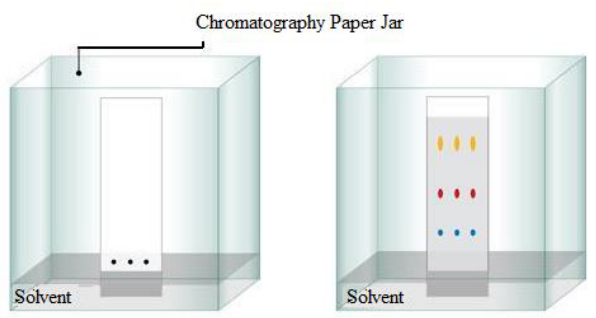
Figure 5: Attendance class cheating case